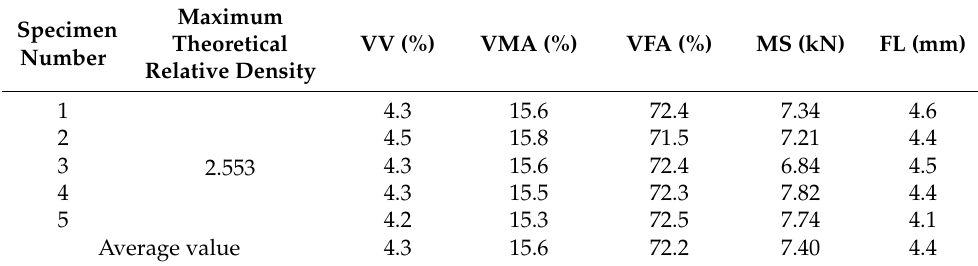
Table 8. Volumetric properties and mechanical performance of LCAs-AM.